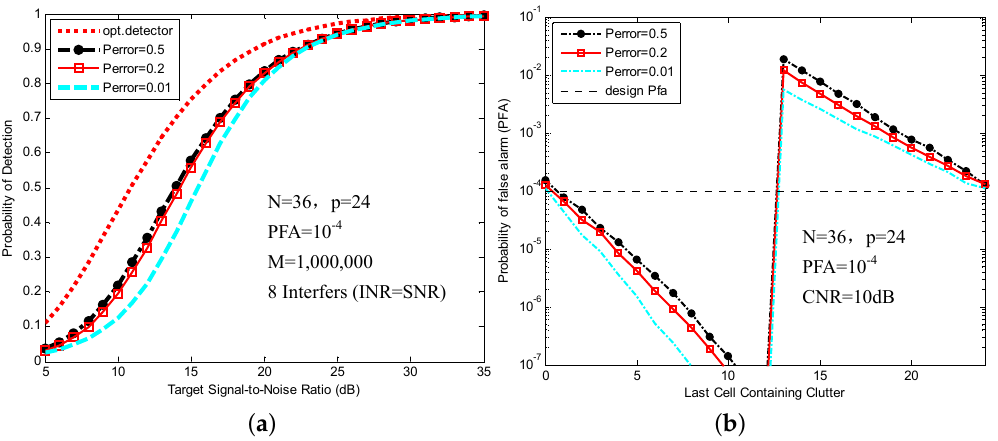
Figure 4. Probability of detection (PD) and probability of false alarm (PFA) values as a function of P error : ( a ) PD comparison in a multiple target situation (eight interference targets); ( b ) PFA comparison in a clutter edge environment (CNR = 10